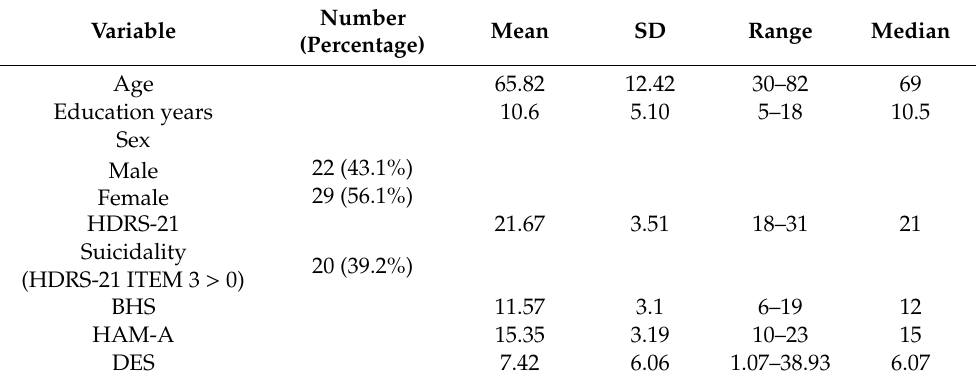
Table 1. Descriptive for the variables of the study ( n =